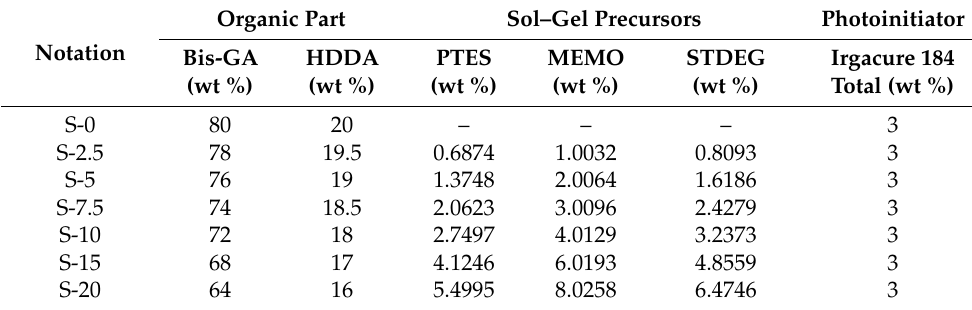
Table 1. Composition of hybrid coatings. Bis-GA: bisphenol-A glycerolate (1 glycerol/phenol) diacrylate; HDDA: 1.6 hexanediol